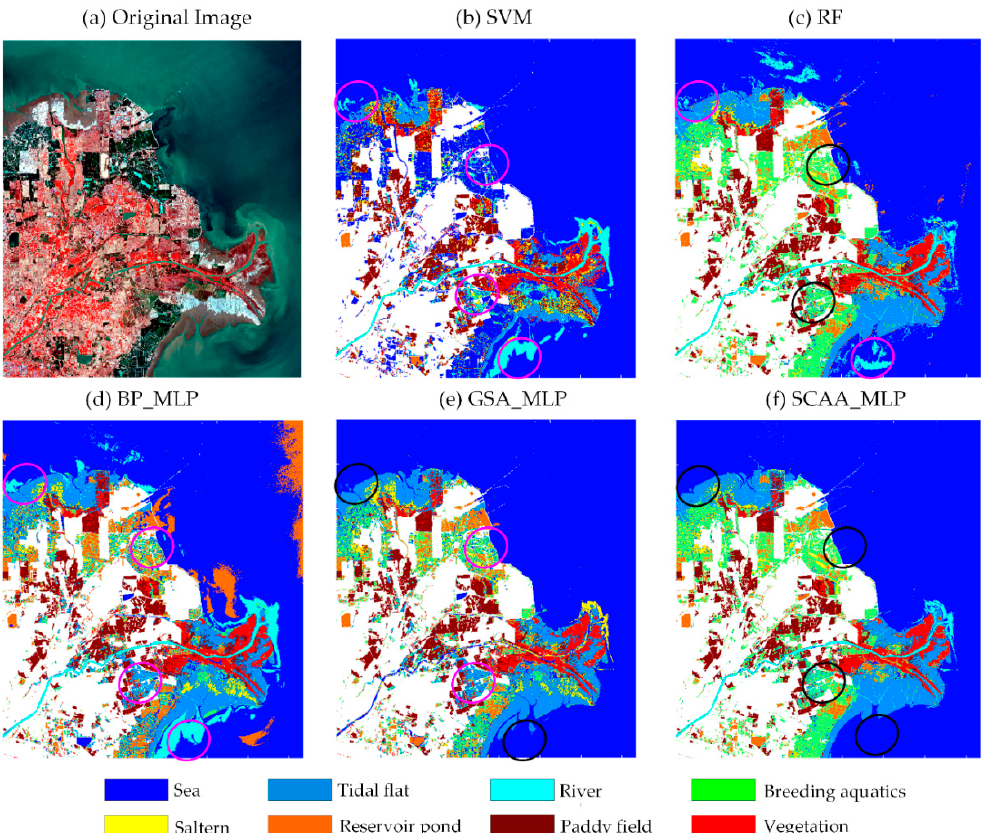
Figure 8. Classification results in Yellow River Delta wetland, with ( a ) an image subset (NIR, G, and B bands only), ( b ) SVM classification, ( c ) RF classification, ( d ) MLP classification, ( e ) GSA_MLP classification, and ( f ) SCAA_MLP classification.